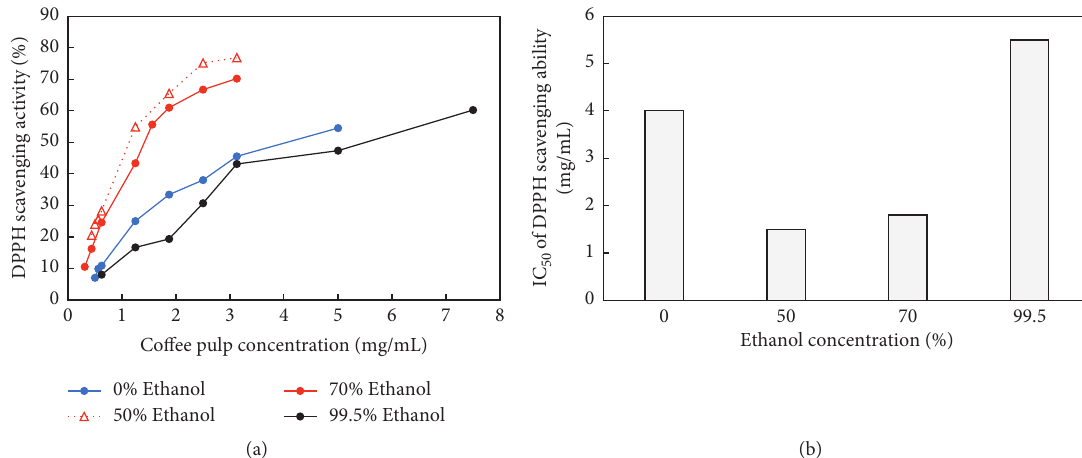
Figure 4: DPPH-free radical scavenging capacity of the coffee pulp extracts obtained using different ethanol concentrations. (a) DPPH-free radical scavenging activity; (b) IC 50 of DPPH-free radical scavenging activity.